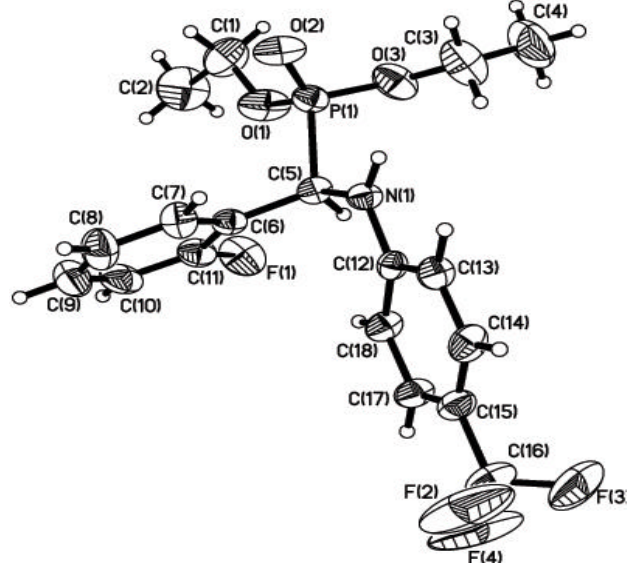
Figure 2. The molecular structure figure of C 18 H 18 F 4 NO 3